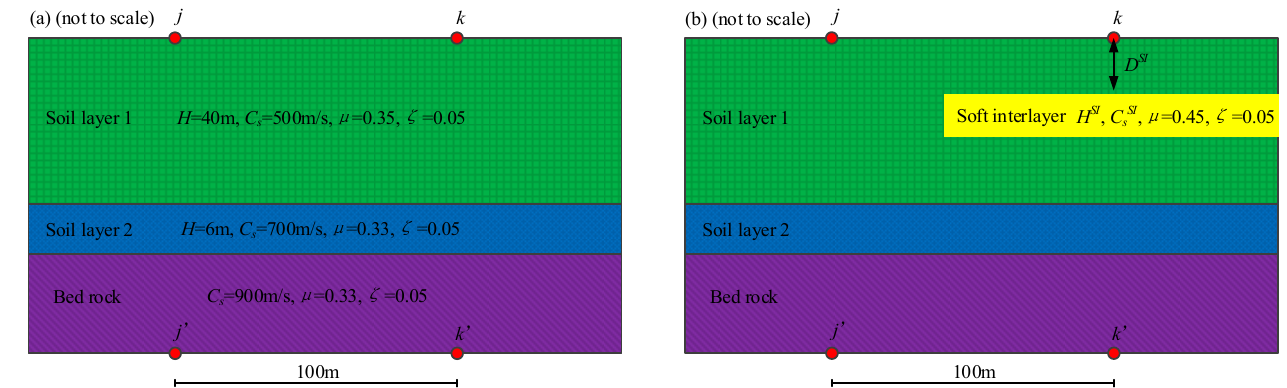
Figure 1. Site conditions for: ( a ) The regular site without soft interlayer; ( b ) the site with soft interlayer.